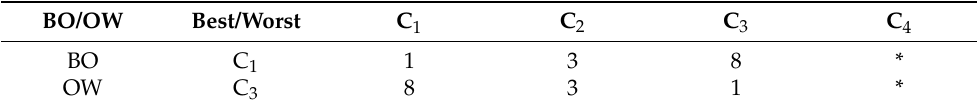
Table 4. The vectors of comparison results.